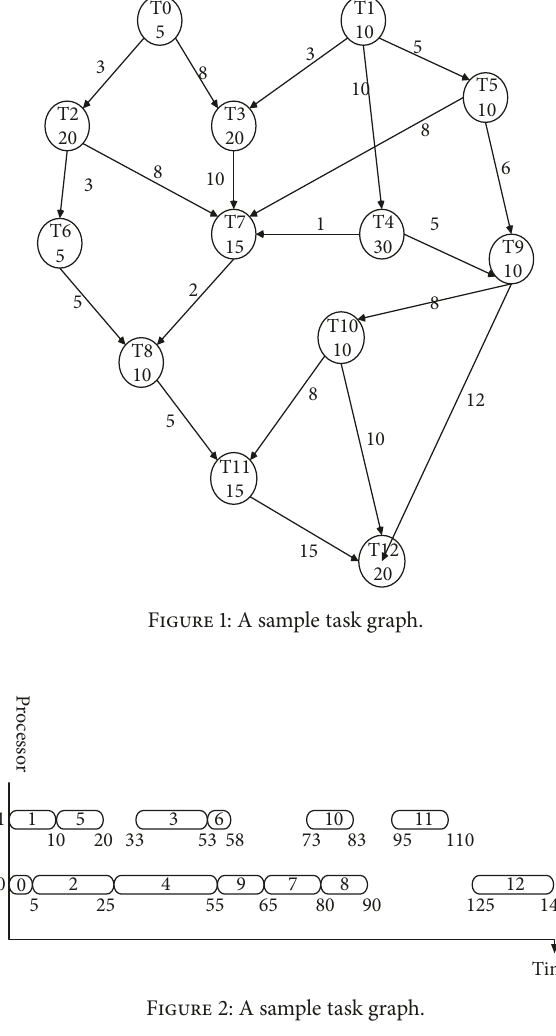
Figure 2: A sample task